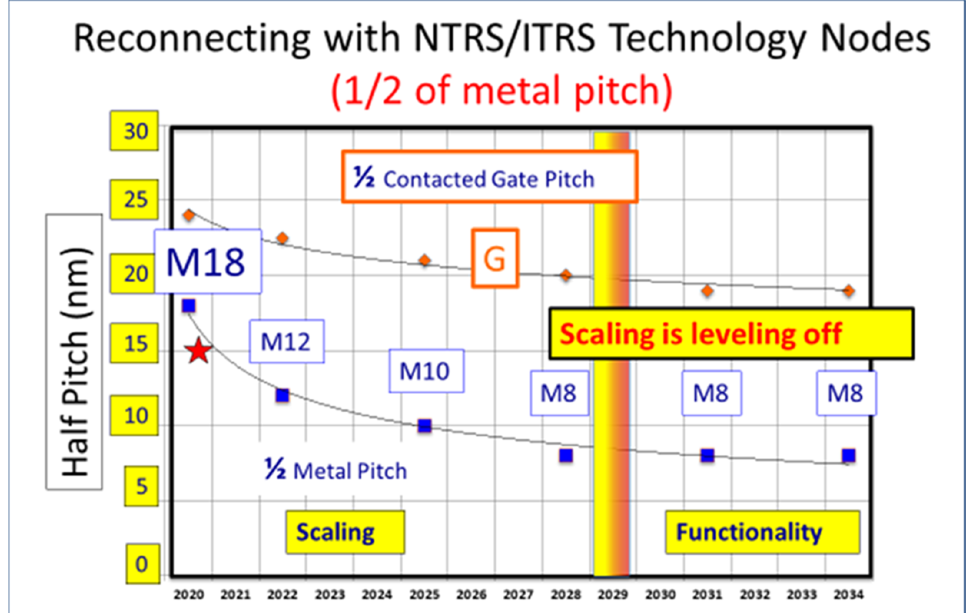
Figure 12. Metal pitch and contacted gate pitch scaling vs. time horizons.